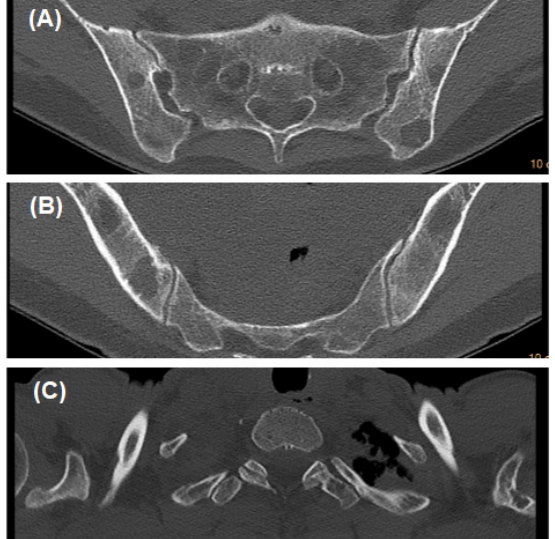
Figure 2. CT scans show areas of osteolysis: ( A ) − in pelvic girdle (the sacrum and iliac bones); ( B ) − in iliac bones; ( C ) − in left scapula.